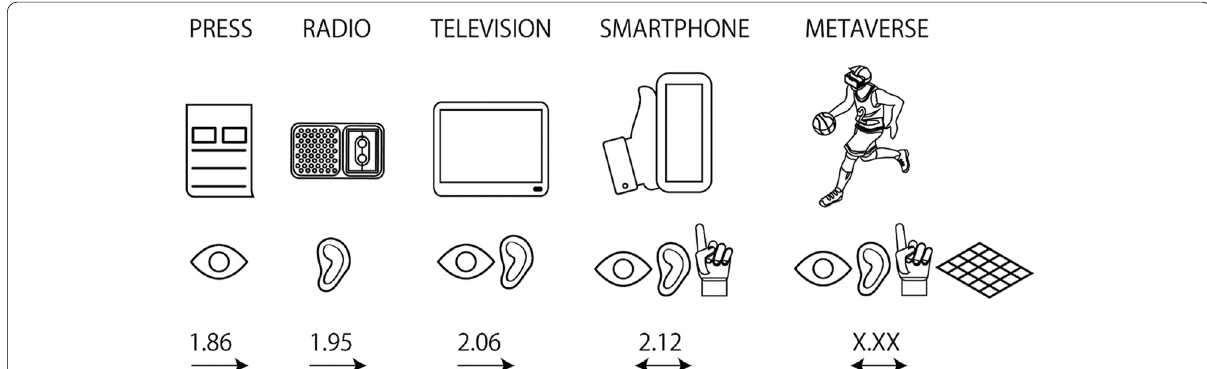
Fig. 4 Different media are explained with icons representing the senses that these media engage, the level of media addiction (intensity) that they provoke [39], and one or two ways of communication that they enable, which is illustrated with one- or two-way arrows below each media. Additionally, there is an icon symbolizing a 3D sense of space, as a characteristic of the